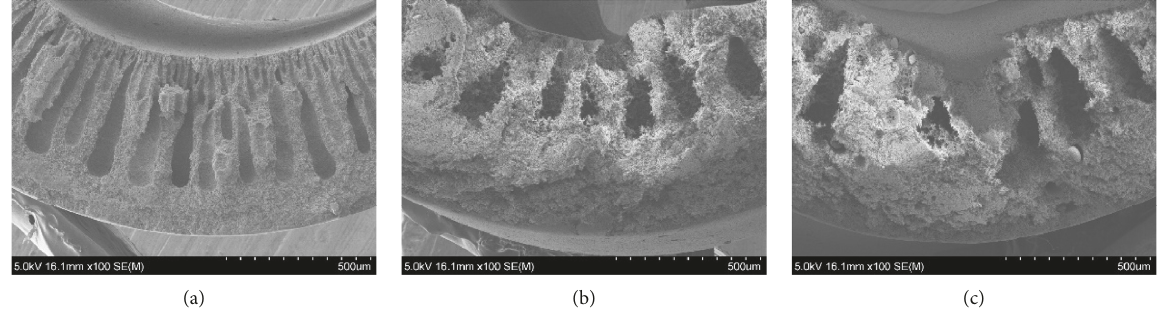
Figure 4: SEM images of hollow-fiber adsorbents manufactured under different slurry velocity conditions: (a) 0.312ml/min; (b) 1.250ml/min; (c) 2.500ml/min.